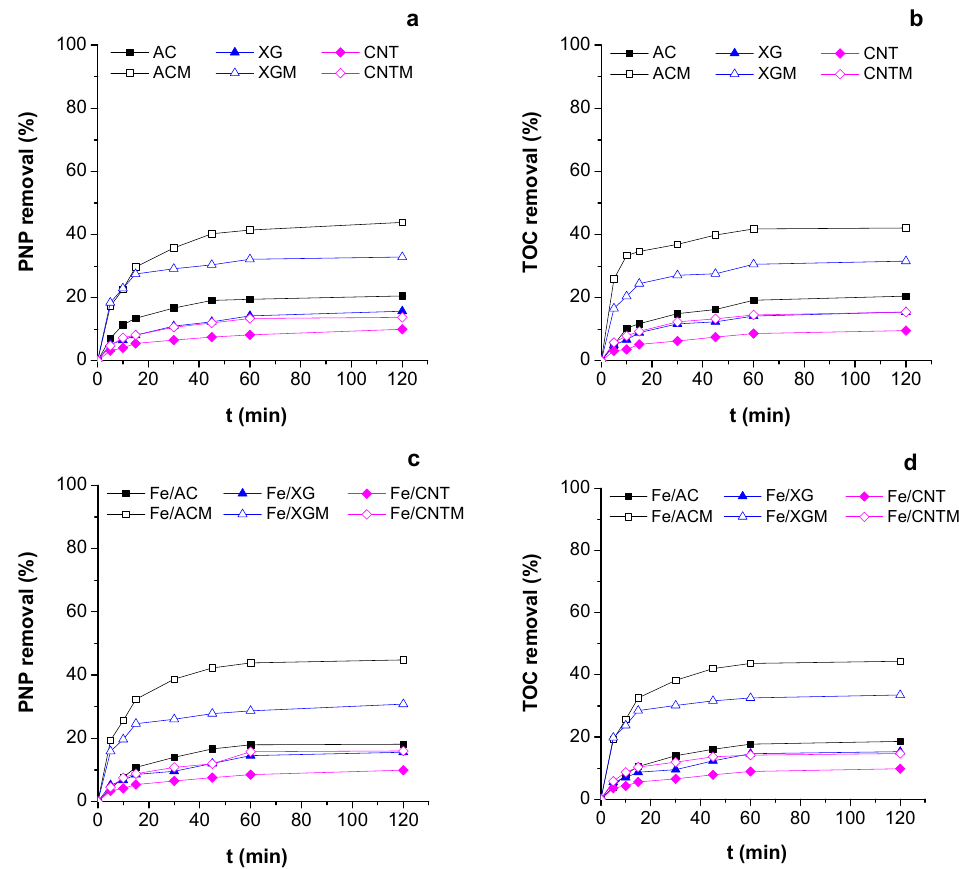
Figure 1. p -nitrophenol (PNP) and total organic (TOC) removal during adsorption with the carbon supports ( a , b ) and with the iron-containing catalysts ( c , d ) (pH = 3.0, T = 30 °C, [support] = 0.25 g L −1 and [PNP] = 3.6 mmol L −1 ).